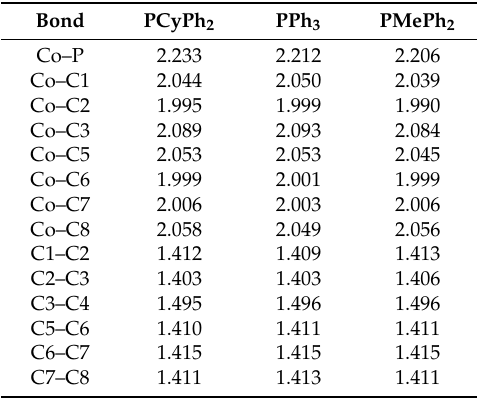
Table 2. Selected M06/6-311g(d) computed bond lengths (Å) for ( η 3 -C 4 H 7 )( η 4 -C 4 H 6 )Co(PRPh 2 ) with R = cyclohexyl (Cy), phenyl (Ph) and methyl (Me). Bond PCyPh 2 PPh